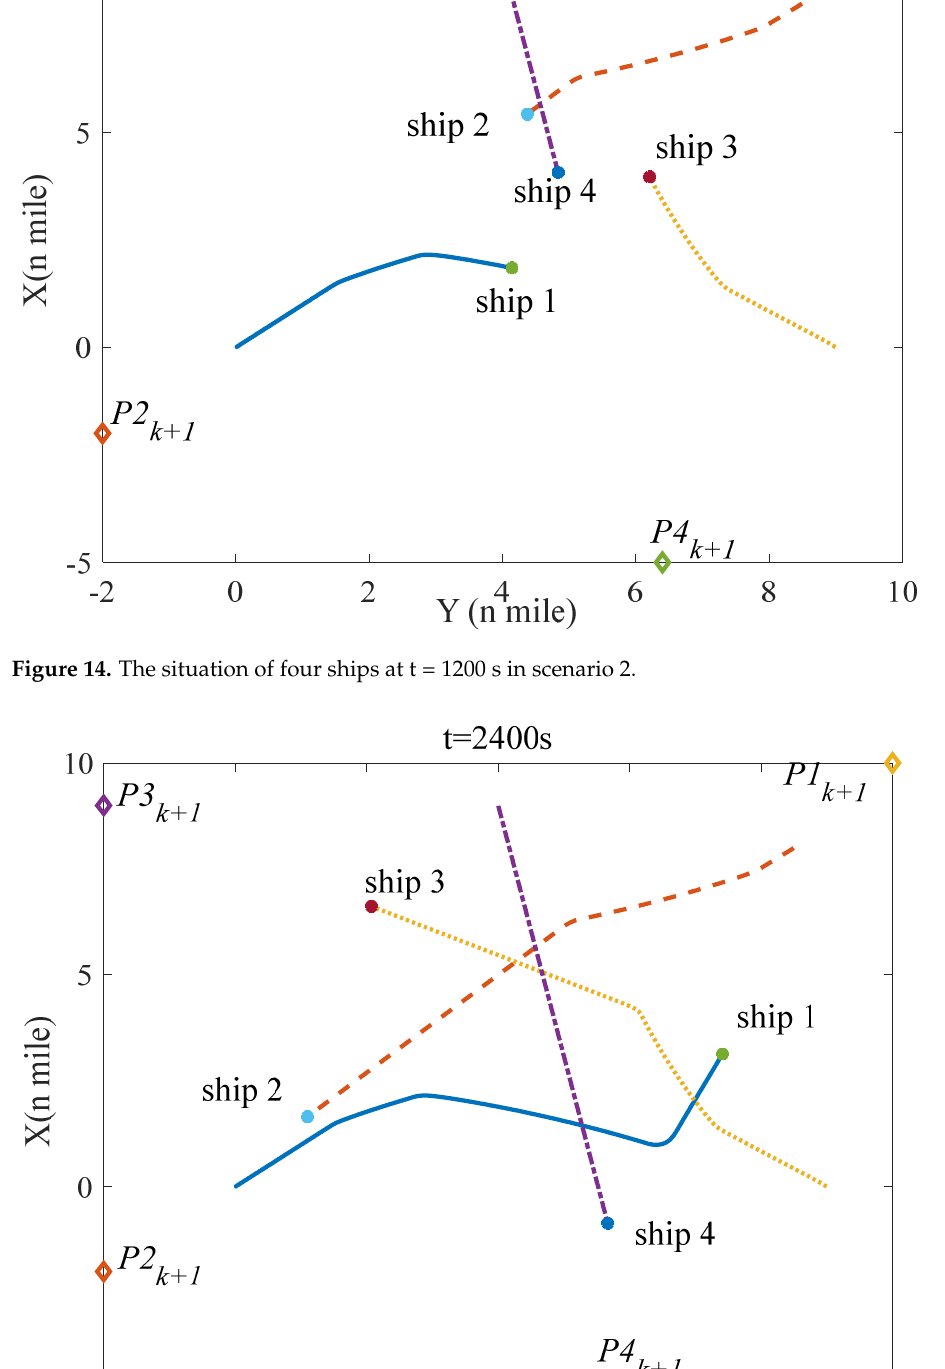
Figure 15. The situation of four ships at t = 2400 s in scenario 2.